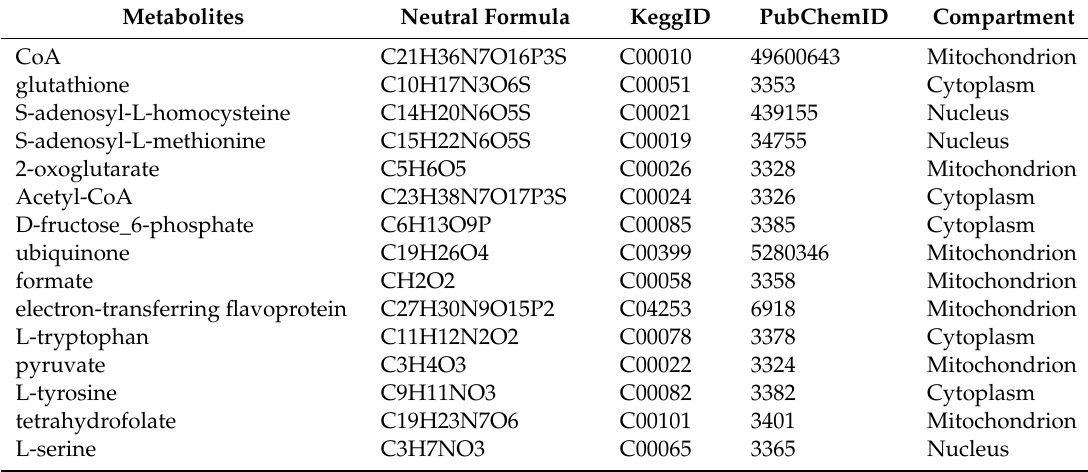
Table 3. Top 15 hub metabolites of the metabolic network of bovine rumen